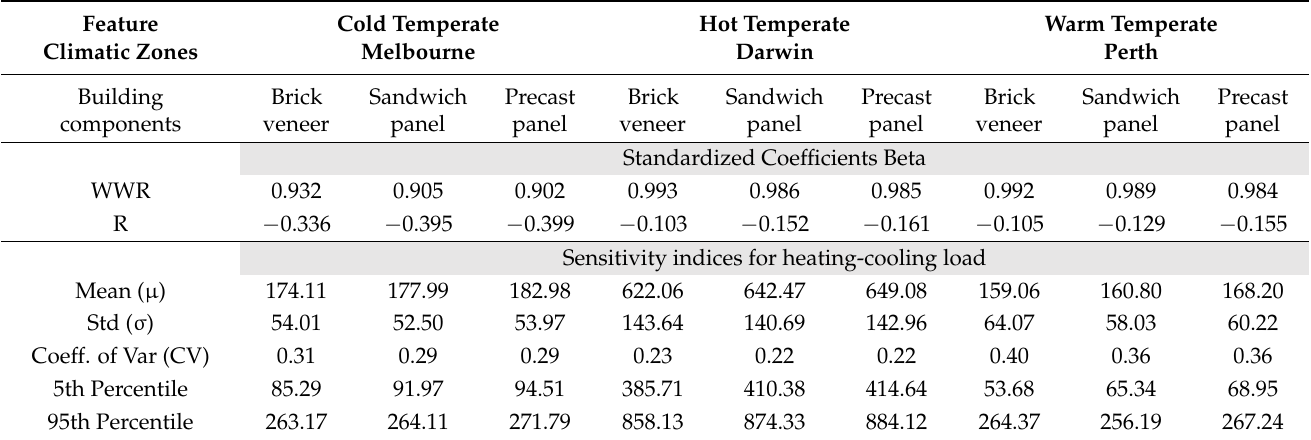
Table 4. Correlation coefficients of sensitivity